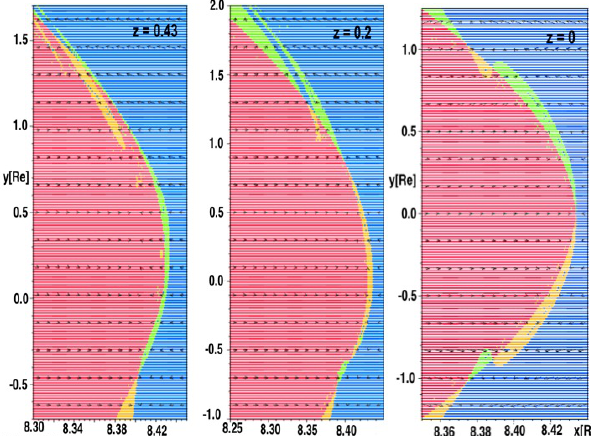
Fig. 14. Magnetic topology at t = 0 for z = 0 . 43, z = 0 . 2 and z = 0 R E . Colors are related to magnetic topology as red, closed; yellow, connected to north; green, connected to south; and blue, solar wind. Arrows indicate flow velocity.